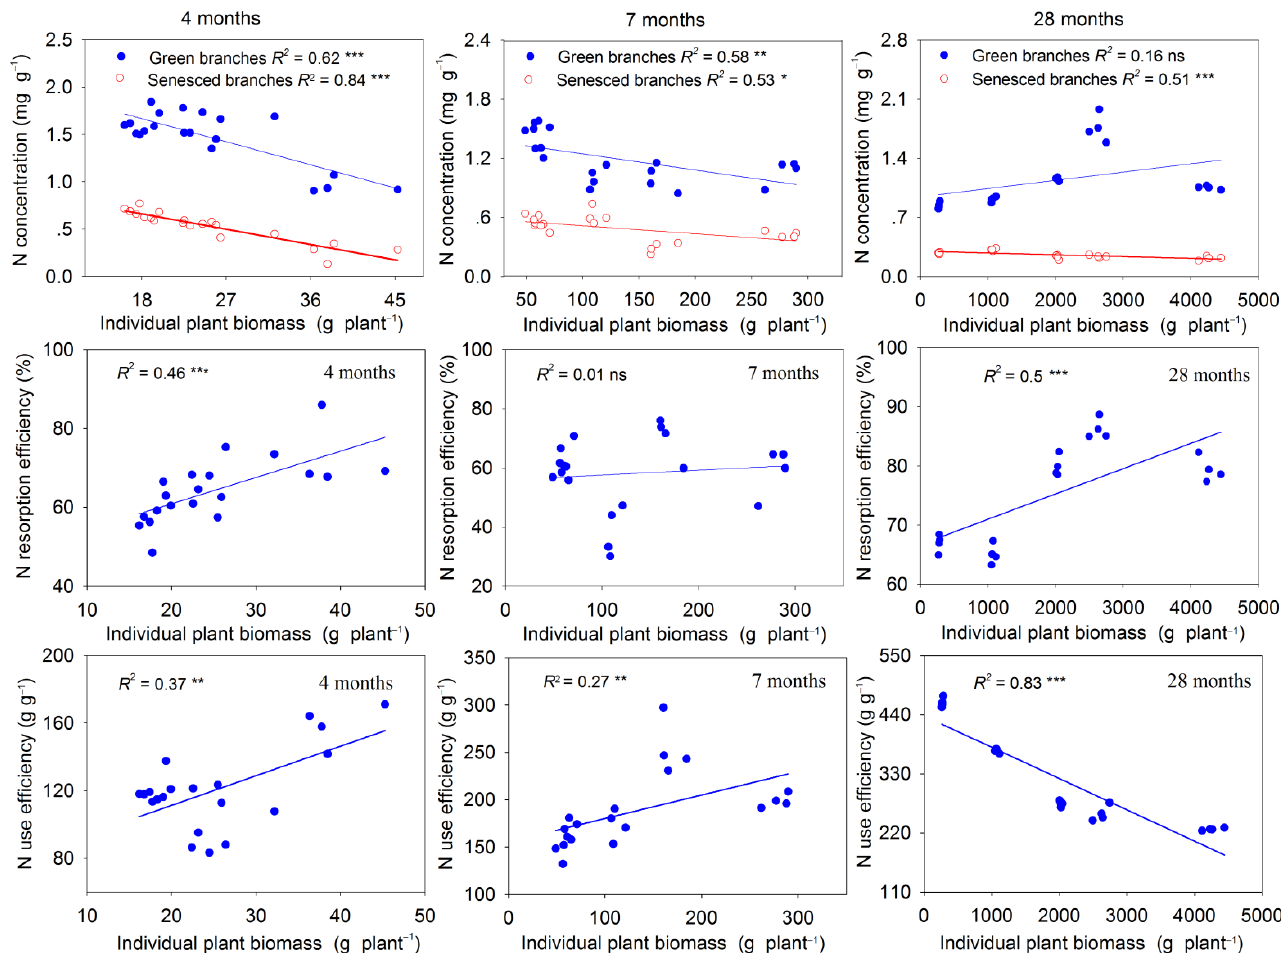
Figure 8. Relationships between N concentration in green and senesced branches, N resorption efficiency, N use efficiency, and individual plant biomass of Calligonum caput-medusae . Note: * p < 0.05; ** p < 0.01; *** p < 0.001; ns indicates no significant.